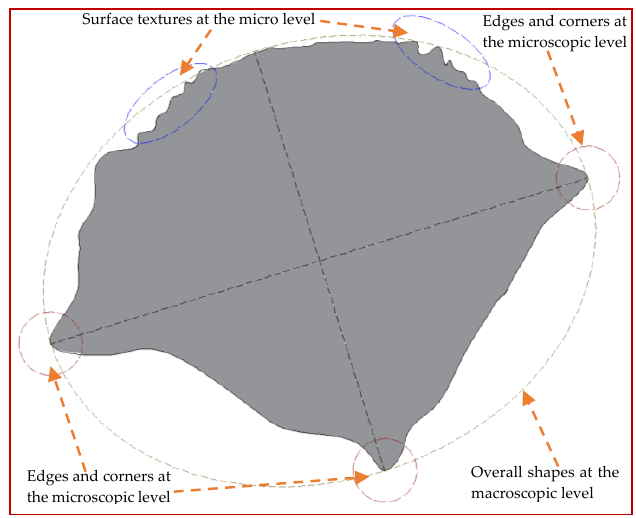
Figure 8. Multi-scale shape characteristics of the sand particle.